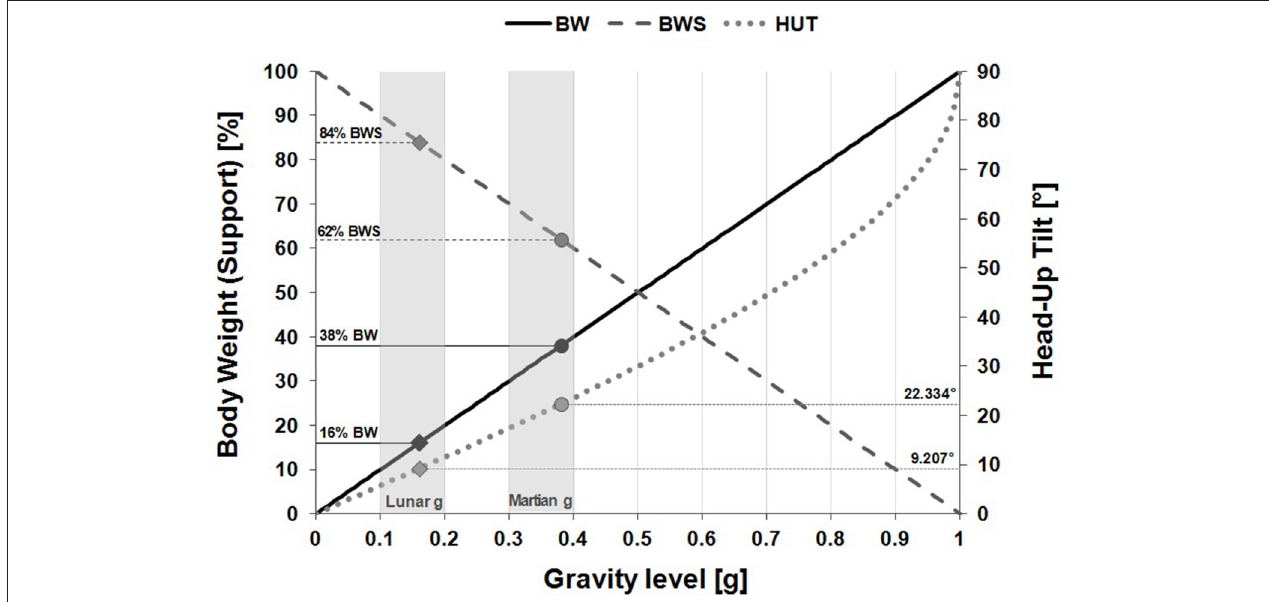
FIGURE 3 | Various levels of gravity expressed in different units. The exact value for Lunar gravity is 0.16g or 9.21 ◦ HUT or 16% BW or 84% BWS. The exact value for Martian gravity is 0.38g or 22.33 ◦ HUT or 38% BW or 62% BWS. The ranges that were considered acceptable for Lunar- and Martian gravity in the present study are shown in gray. The exact values for Lunar and Martian gravity and each unit are depicted through solid diamonds and circles. BW, Body weight (in %); BWS, Body weight support (in %); HUT, Head-up tilt (in